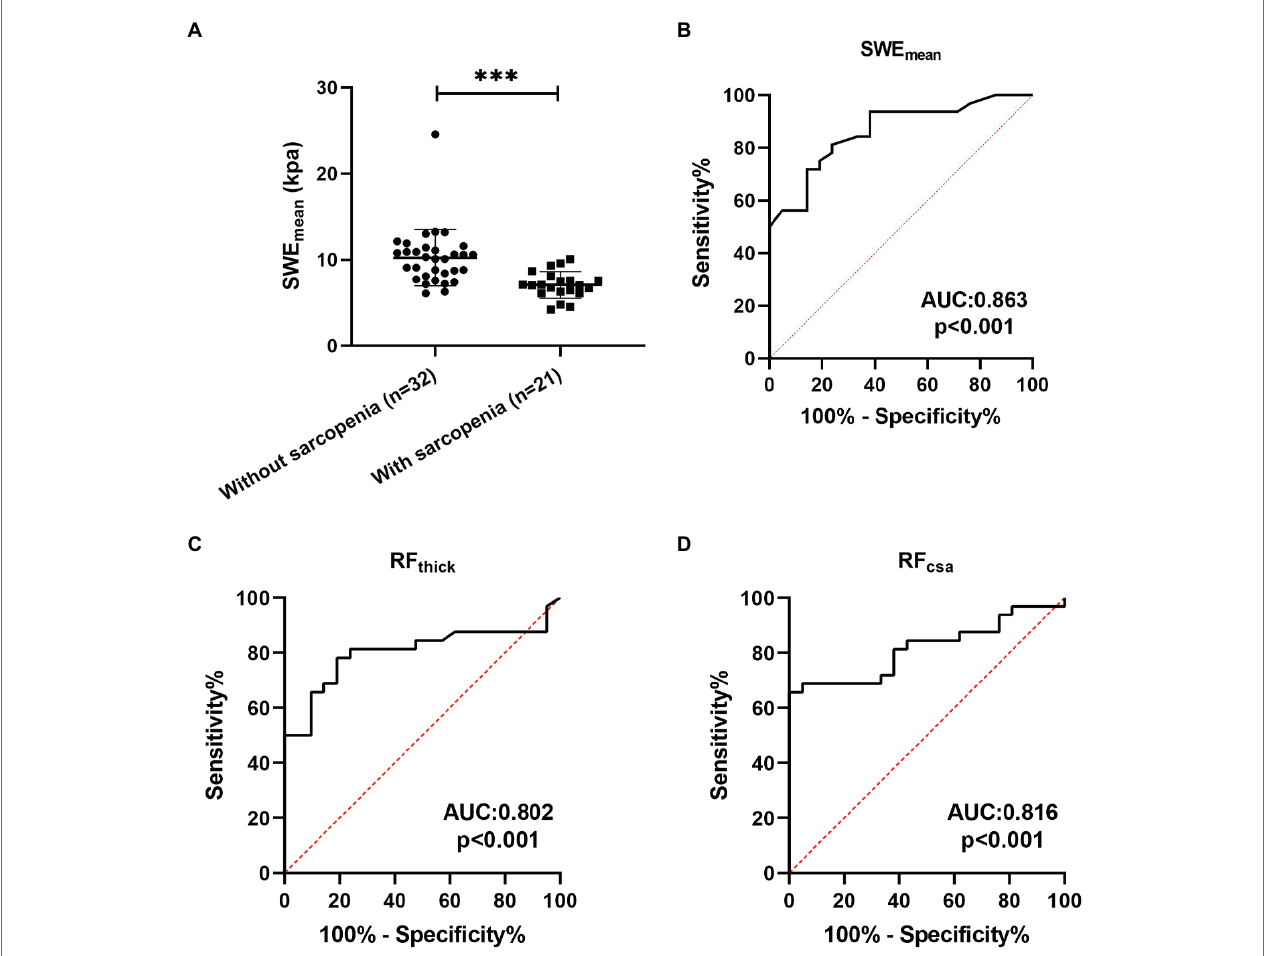
FIGURE 4 | The predictive value of SWE mean. (A) The SWE mean were differed between patients with sarcopenia and patients without sarcopenia; (B-D) Receiver operating characteristic curve analysis of the mean elasticity indices of rectus femoris ultrasound elastography and thickness and cross-sectional area of the rectus femoris for predicting sarcopenia in patients with COPD. SWE mean : mean SWE elasticity index; RF thick : the thickness of rectus femoris; and RF csa : the cross-sectional area of rectus femoris. *** p